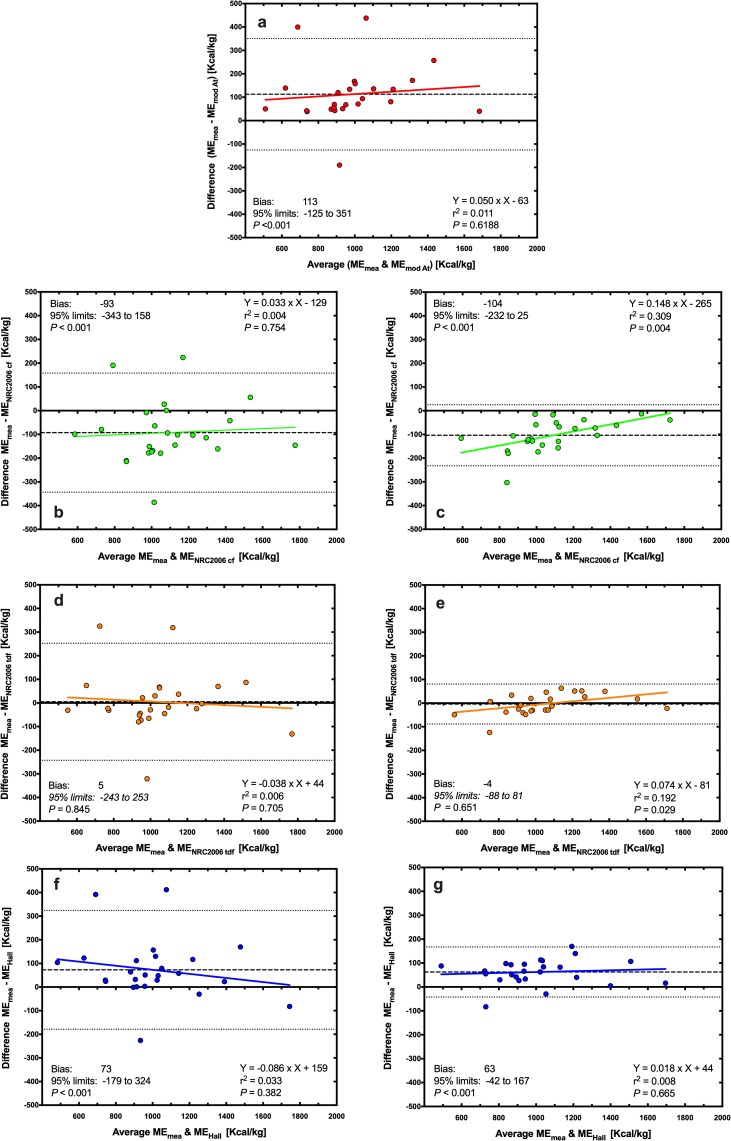
Bland-Altman plot depicting the relationship between measured and predicted metabolisable energy (ME) content in wet canine diets.The y- and x-axes depict the difference between and the average of the measured and predicted ME content of dry canine diets, respectively. The points represent results for individual foods, the dashed back line depicts the average bias, the dotted black lines depict the 95% confidence limits to the agreement, and the solid coloured line represents the trendline from linear regression analysis. Different figures represent predictions made with MA (red, a), NRC 2006cf (green; b: predicted GE; c: measured GE), NRC 2006tdf (orange; d: predicted GE; e: measured GE), and Hall equations for dogs (blue; f: predicted GE; g: measured GE).